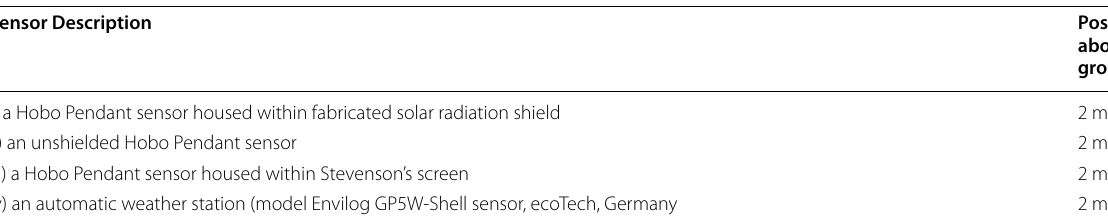
Table 1 Description of the sensors used in recording temperatures Sensor Description Position